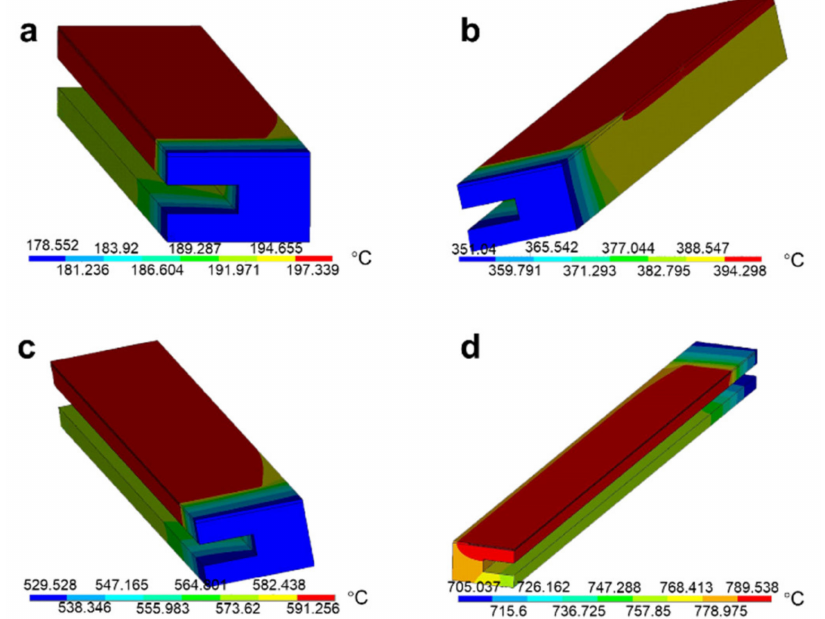
Figure 3. Temperature distribution of the nitrogen–oxygen sensors at different heating temperatures: